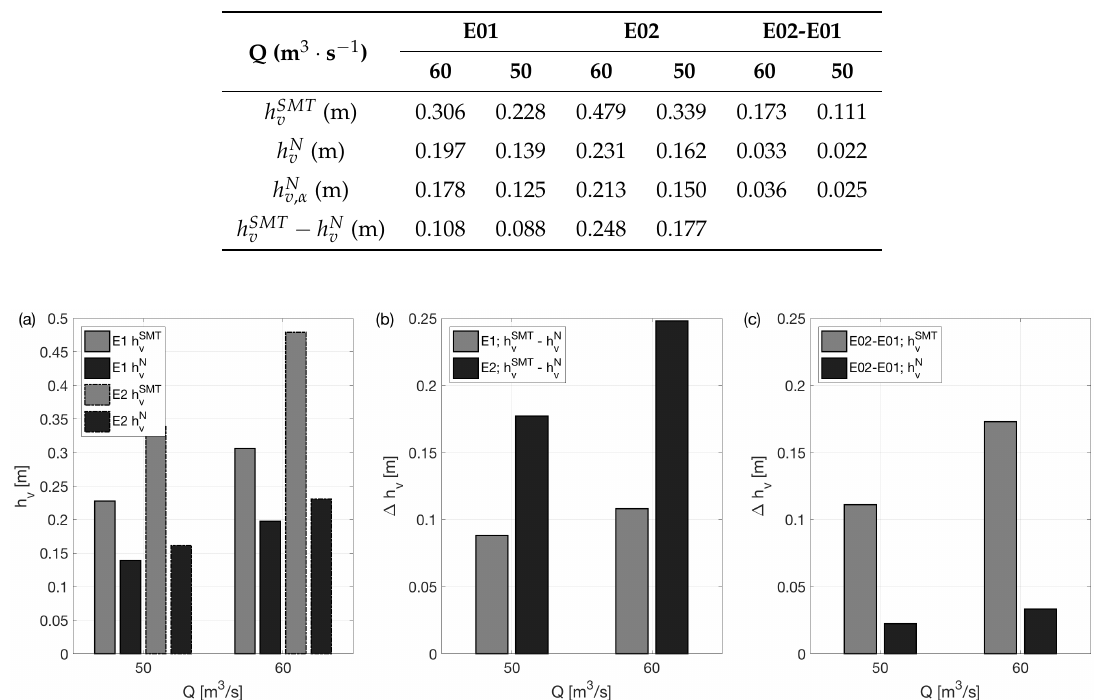
Table 1. Comparison of the local head loss h v ( m ) of the scale model test (SMT) with a modified trash rack and the numerical simulation (N) with no additional loss caused by the trash rack for two different discharges Q and two different variations of trash racks—all dimensions in nature scale.